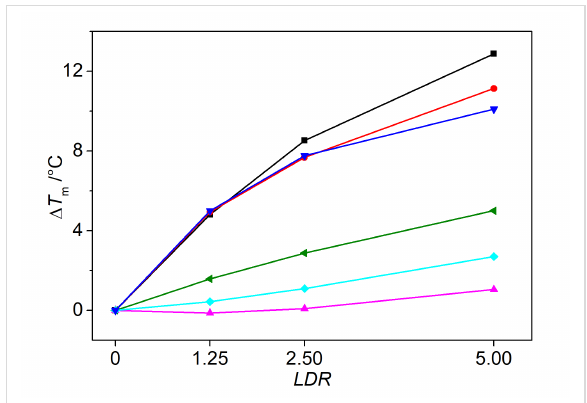
Figure 2: Melting temperatures, Δ T m , of G4-DNA ( c DNA = 0.2 µM) F21T (black), F21T plus ds26 (15 equiv, red), FkrasT (blue), FmycT (green), FkitT (light blue), and Fa2T (magenta) in the presence of 4e at different LDR = 0.00, 1.25, 2.50, 5.00 in Na-cacodylate buffer ( c K+ = 10 mM, pH 7.2); estimated error ±0.5 °C. F21T: fluo-d[(G 3 TTA) 3 G 3 ]-tamra; Fa2T : fluo-d[(ACAG 4 TGTG 4 ) 2 -tamra; FmycT : fluo-d(TGAG 3 TG 3 TAG 3 TG 3 TA 2 )-tamra; FkrasT : fluo-d(AG 3 CG 2 TGTG 3 A 2 GAG 2 A)-tamra]; FkitT : fluo-d(AG 3 AG 3 CGCTG 3 AG 2 AG 3 )-tamra], fluo = fluorescein, tamra = tetramethylrhodamine; ds26 : d(CA 2 TCG 2 ATCGA 2 T 2 CGATC 2 GAT 2